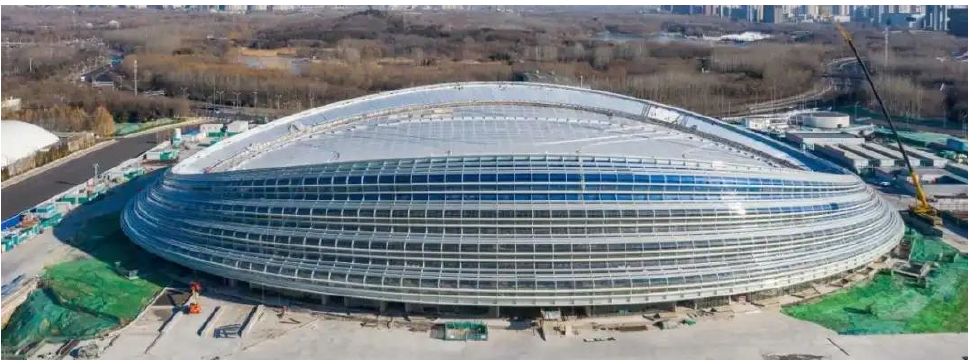
Figure 14. National Speed Skating Oval (NSSO).